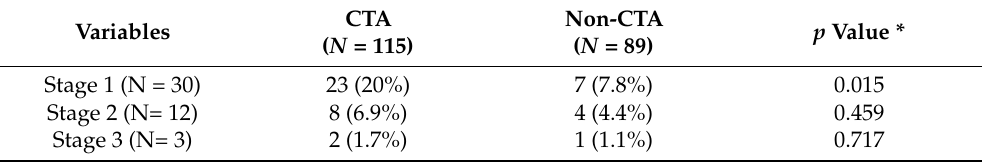
Table 3. Subgroup analysis for computed tomography usage and postoperative kidney injury